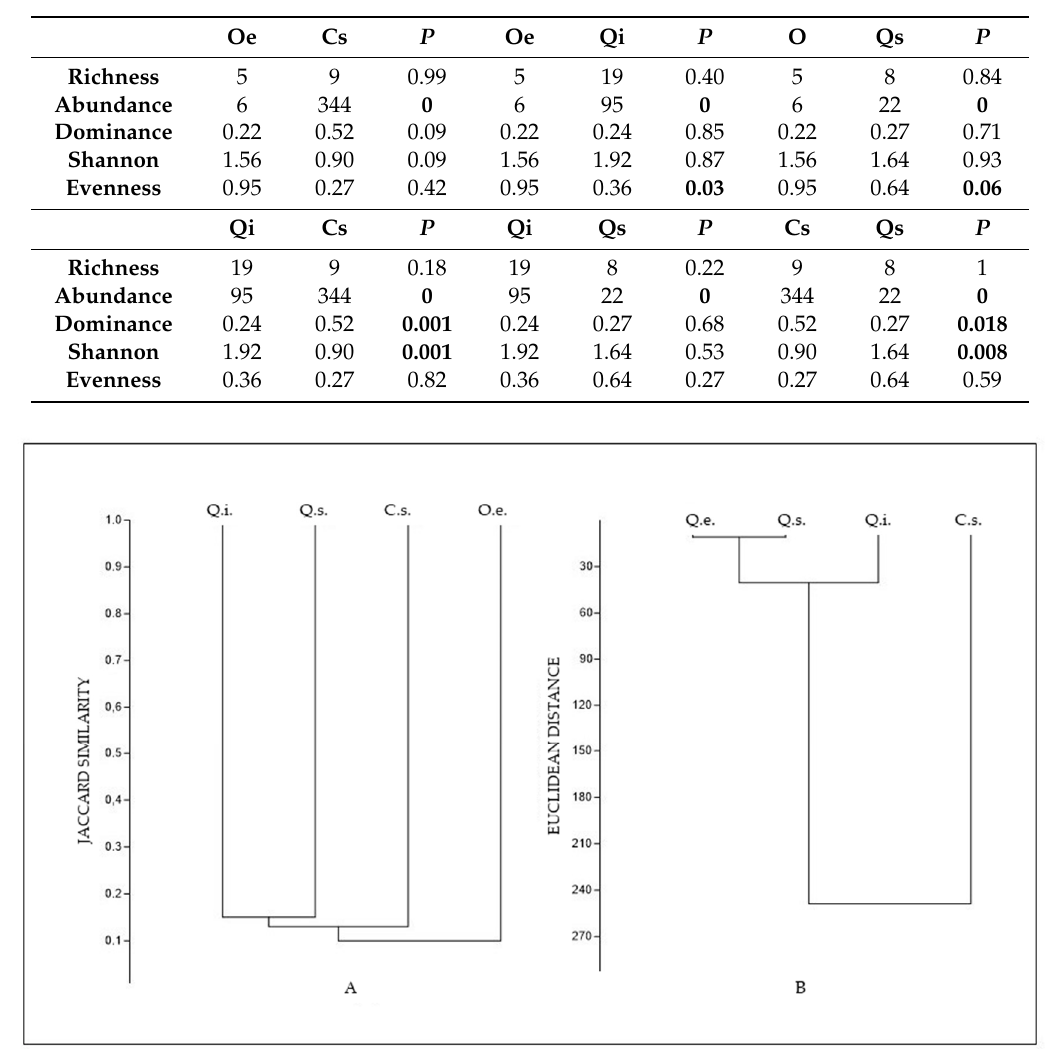
Figure 1. Grouping dendrograms for tree species. ( A ) Qualitative grouping dendrogram obtained with the Jaccard’s similarity index; ( B ) quantitative grouping dendrogram obtained with Euclidean distances. O.e.: O. europaea ; C.s.: C. siliqua ; Q.i.: Q. ilex ; Q.s.: Q. suber .